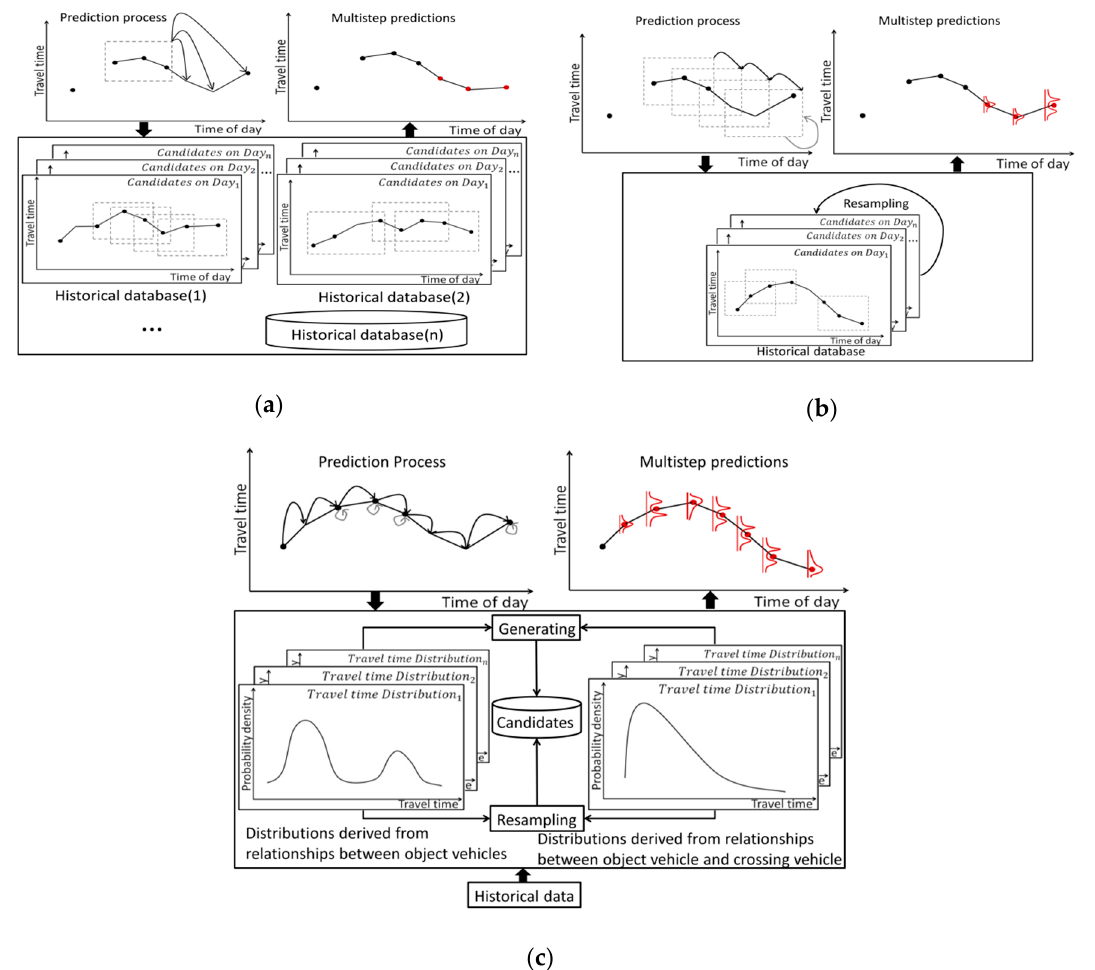
Figure 6. Models used in this study: ( a ) kNN-based model; ( b ) PF-based model; ( c ) Proposed model.